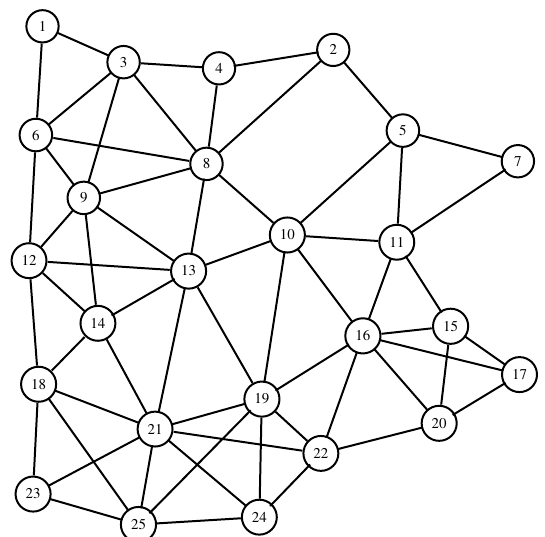
Fig. 4. Graphic representation of the underlying graph